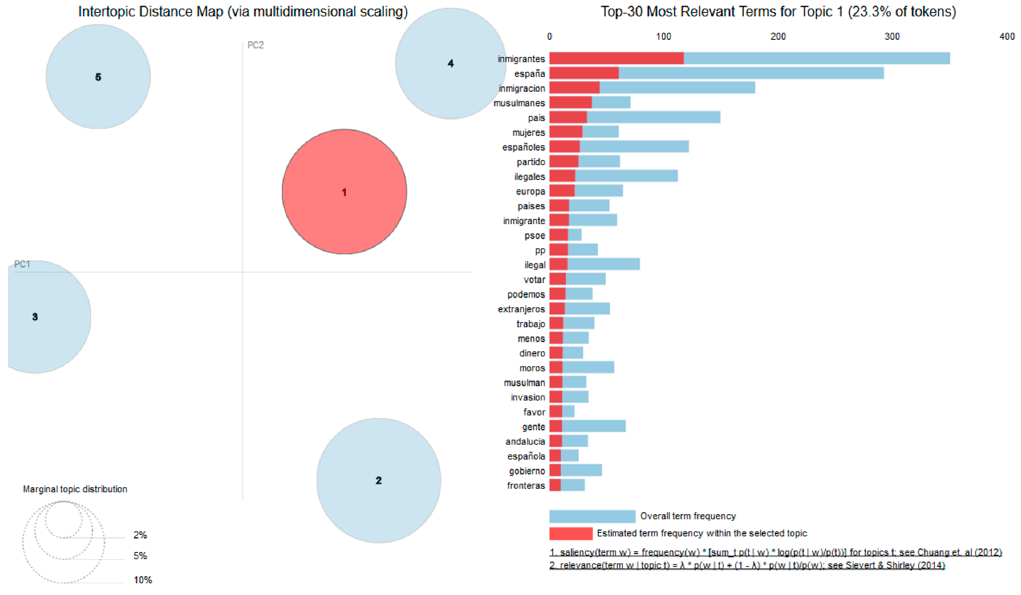
Figure 4. Interactive map of topic 1, ƛ = 1.